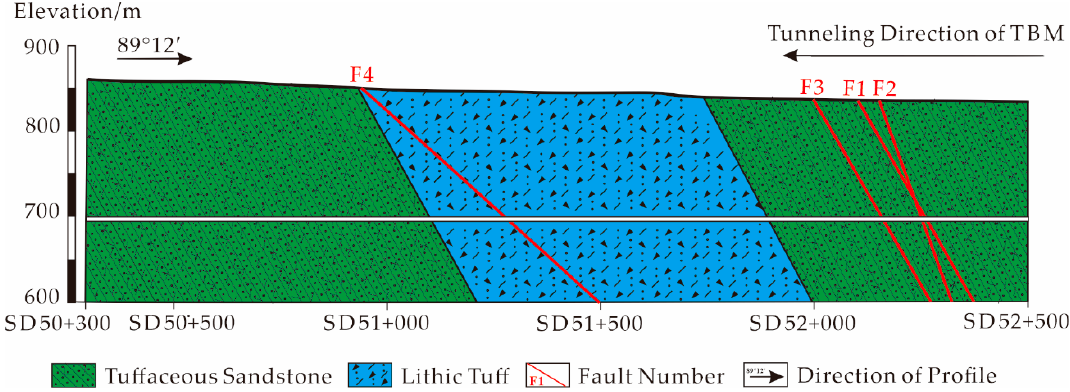
Figure 2. The geological profile of the SS (Shuang-san) tunnel from SD52+500 to SD50+300. TBM, tunnel boring machine.